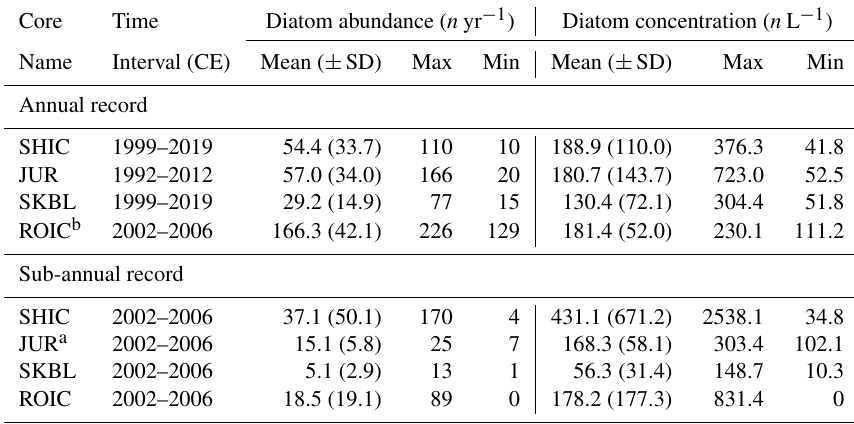
Table 4. Basic statistics for the diatom abundance and diatom concentration records from each ice core. Core Time Diatom abundance ( n yr − 1